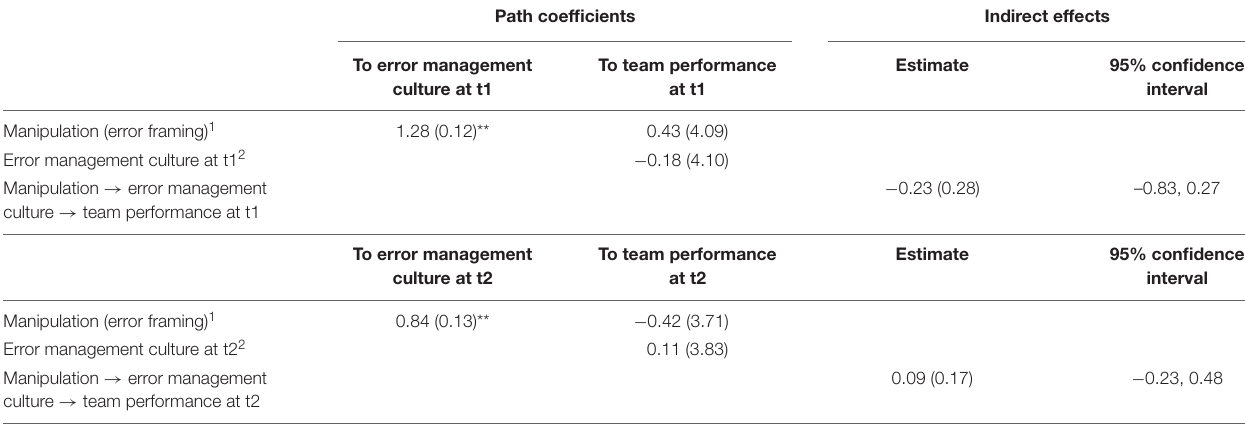
TABLE 3 | Mediation analysis in Study 1.